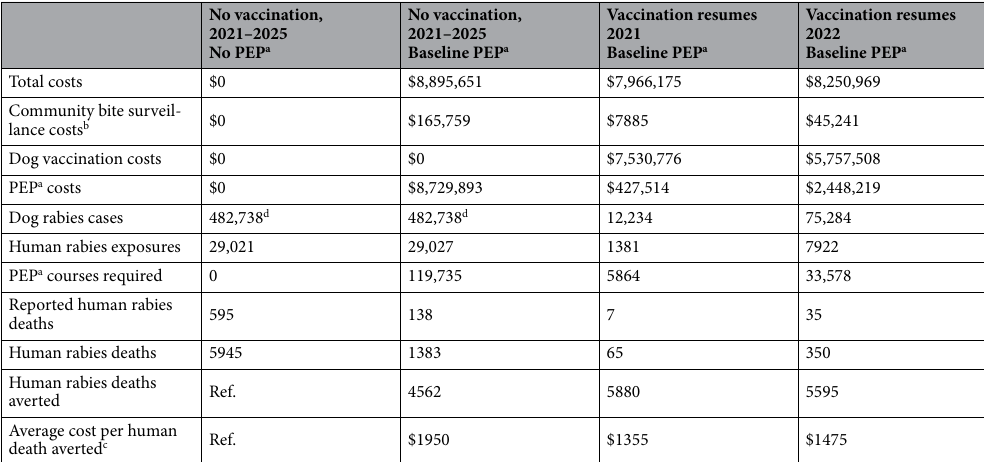
Table 1. Five-year cost and health outcomes associated with combinations of dog rabies vaccination programs and human PEP: 2021–2025. a PEP = post-exposure prophylaxis. The baseline PEP assumption is that 80% (outside Ouest Department) or 85% (Ouest Department) of humans exposed to a suspected rabid dog receive PEP, and that 1/5 suspected exposures are true rabies exposures. In people with true rabies exposures, PEP reduces the probability of death. PEP coverage is assumed to remain fixed throughout 2021–2025 in all scenarios. b Community bite surveillance costs include costs associated with bite investigation and lab tests. We assume these costs occur under all scenarios except the no-vaccination, no-PEP scenario. c The average cost-effectiveness ratios were calculated by dividing the total program costs by the number of human deaths prevented in each scenario, compared to the no-vaccination, no-PEP scenario . d With approximately 700,000 dog population at any time, 482,738 dogs over 5 years corresponds to about 8000 rabid dogs/month, equivalent to an attack rate of approximately 1.1% dogs per